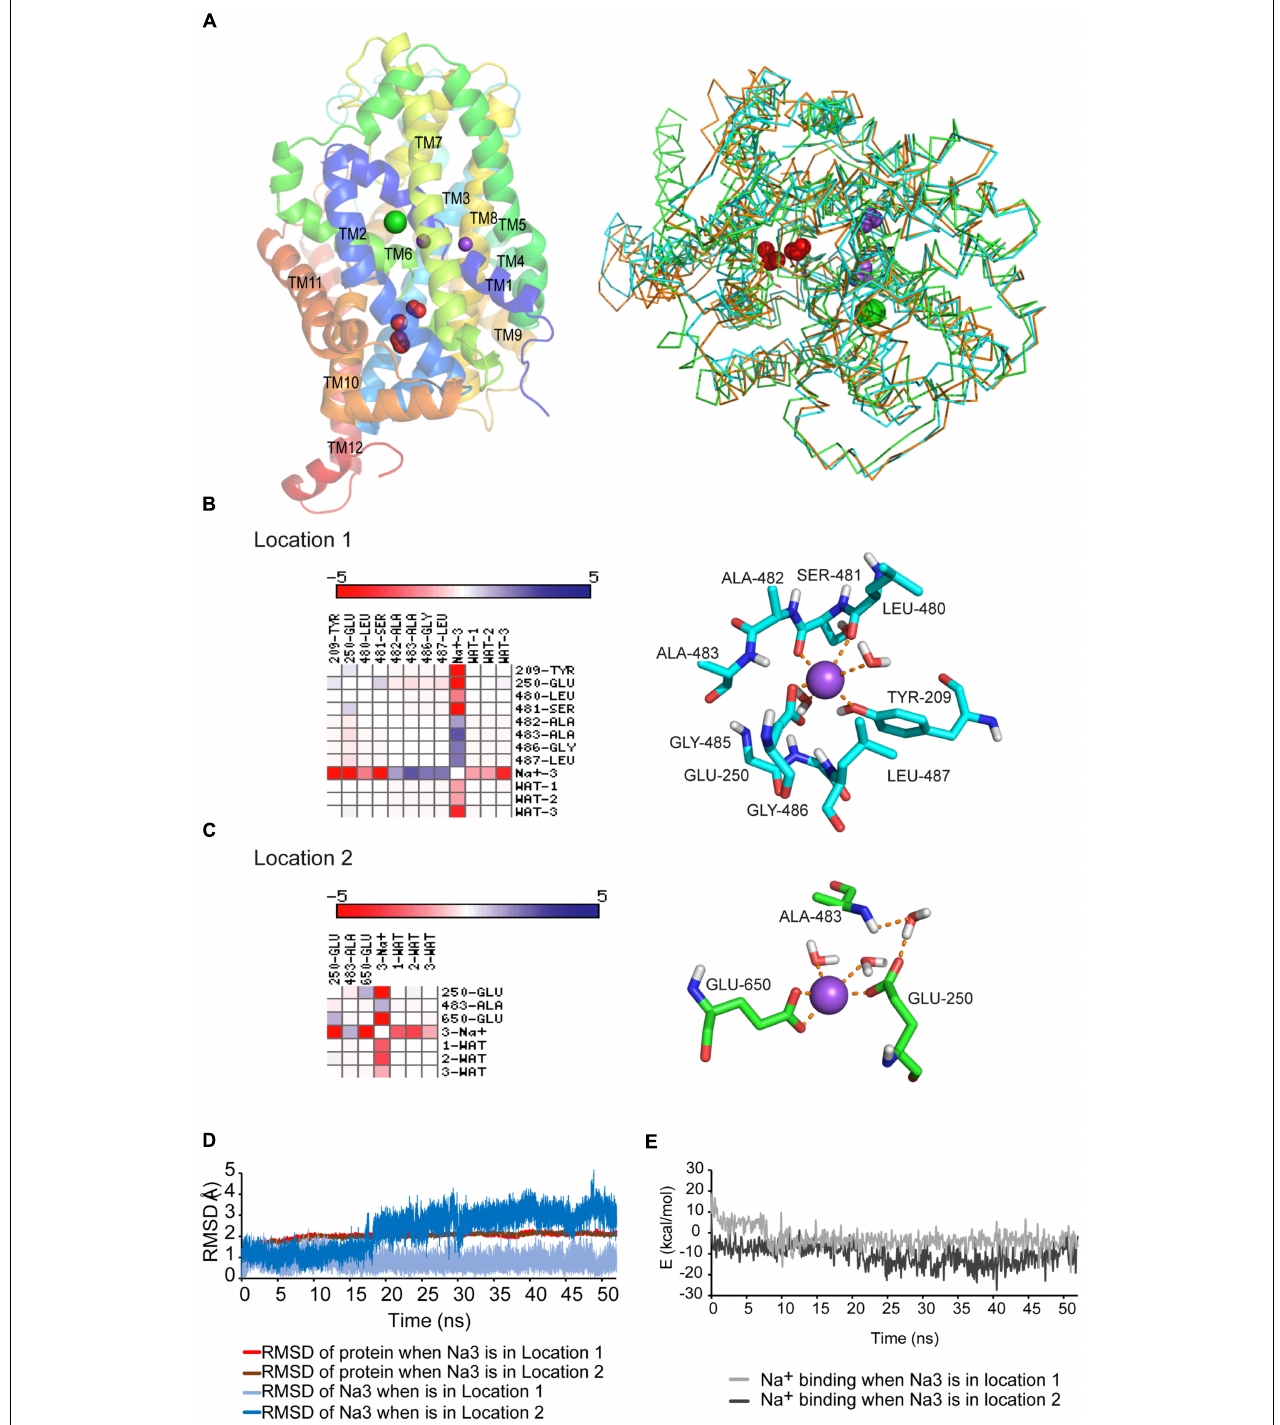
FIGURE 1 | (A) GlyT2 dDAT homology model. Left: PyMol-generated GlyT2 lateral view is shown in a cartoon representation with conserved Na1 and Na2 as purpled spheres and chloride ion as green sphere. The water molecules found in several NSS crystals (red spheres) are surrounding the unwound portion of TM6. Right: structure alignment in PyMol of GlyT2 model, LeuT Aa and dDAT crystals. 90% of the LeuT Aa and dDAT crystals in PDB show 2 crystallographic water molecules in locations 1 and/or 2. The three structures are shown as ribbon, GlyT2 model is colored in orange, LeuT Aa in green, and d DAT in cyan. The waters are depicted as red spheres and residues Glu250 and Glu650, which bind waters, are shown in stick representation. (B) Interaction matrix and lateral view of Na3 placed in location 1. (C) Interaction matrix and lateral view of Na3 placed in location 2. Cations are shown as purple spheres. Residues are shown in stick representation. (D,E) Root-mean-square-deviations (RMSD) (D) and energy profile (E) along the 50 ns MD simulations with sodium placed in location 1 or 2.